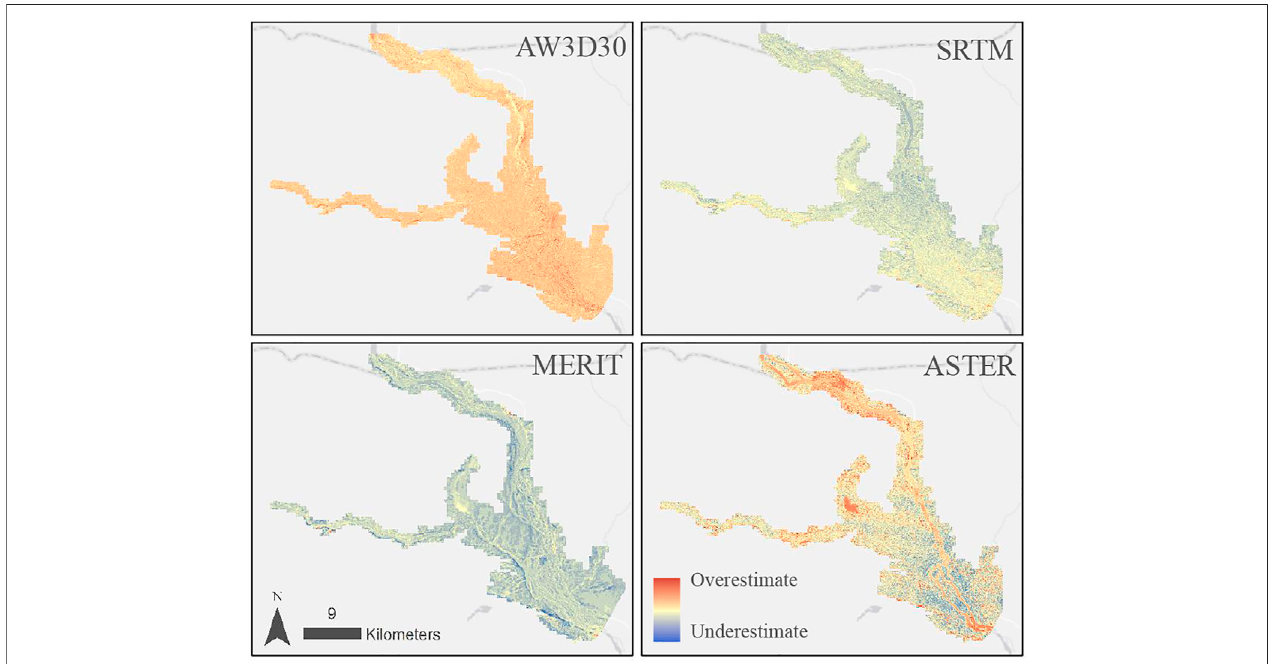
FIGURE3| SpatialdifferencesoftheglobalDEMsfromtheLiDARDEM.RedrepresentsareasthatarepositiveandtheglobalDEMoverestimatesheightcompared to the LiDAR DEM, yellow no difference in the global DEM and the LiDAR, and blue is negative meaning the global DEM underestimates the height, compared to the LiDAR DEM.